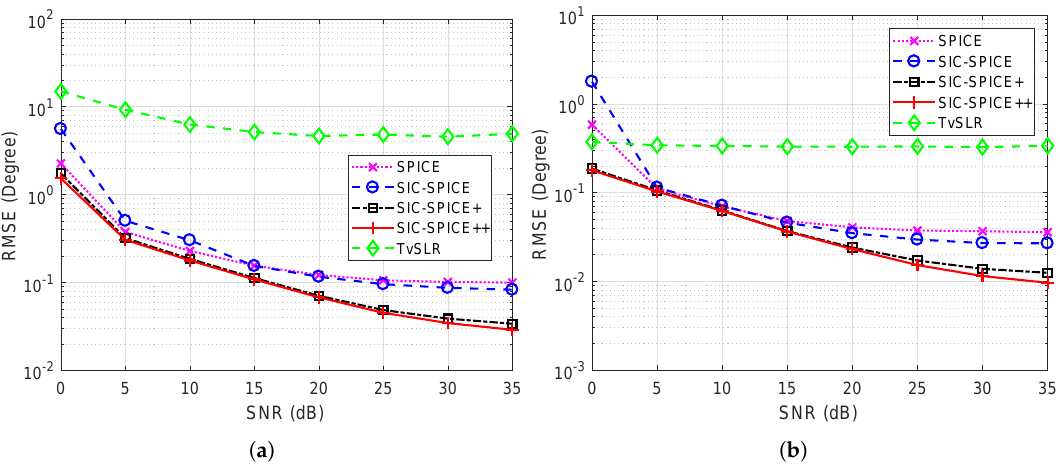
Figure 5. RMSE of different algorithms versus SNR. ( a ) RMSE of the first source ( b ) RMSE of the third